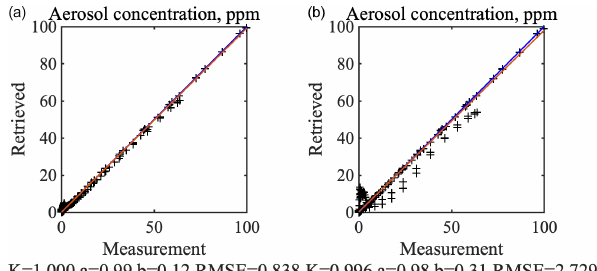
Figure 31. Comparison between simulated and retrieved aerosol vertical distributions in noise-free (a) and noisy (b)